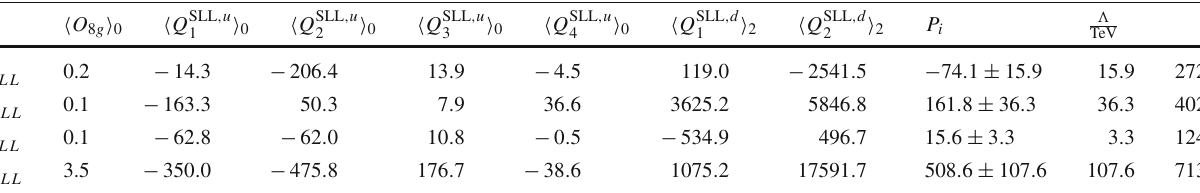
Table 8 Coefficients p ( I ) and P i of the master formula (18)–(19) as well as suppression scale (cid:8) (last column) from RLRL type operators of ij